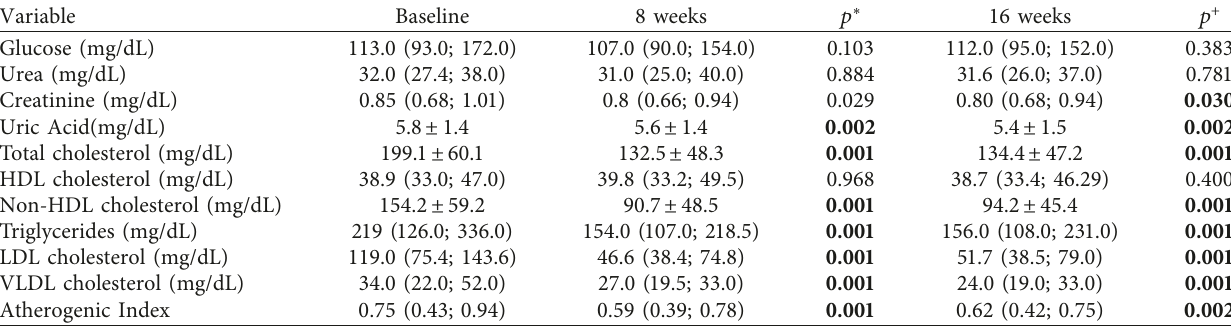
Table 2: Changes in biochemical markers at 8 and 16 weeks of treatment.